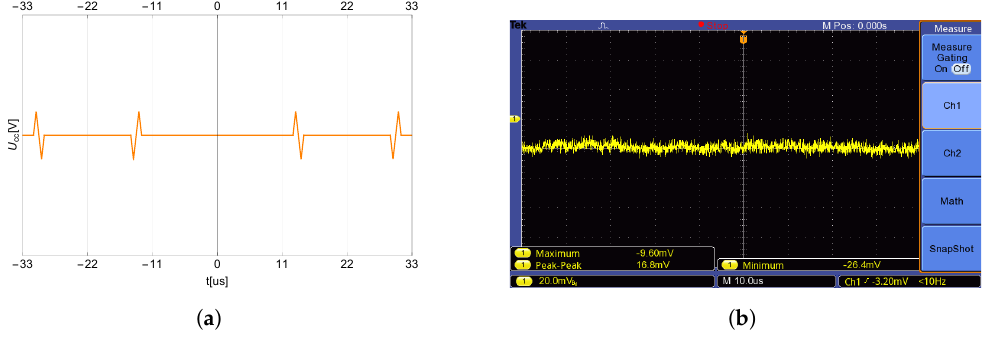
Figure 12. Expected supply current overshoot ( a ) Real supply current overshoot ( b )